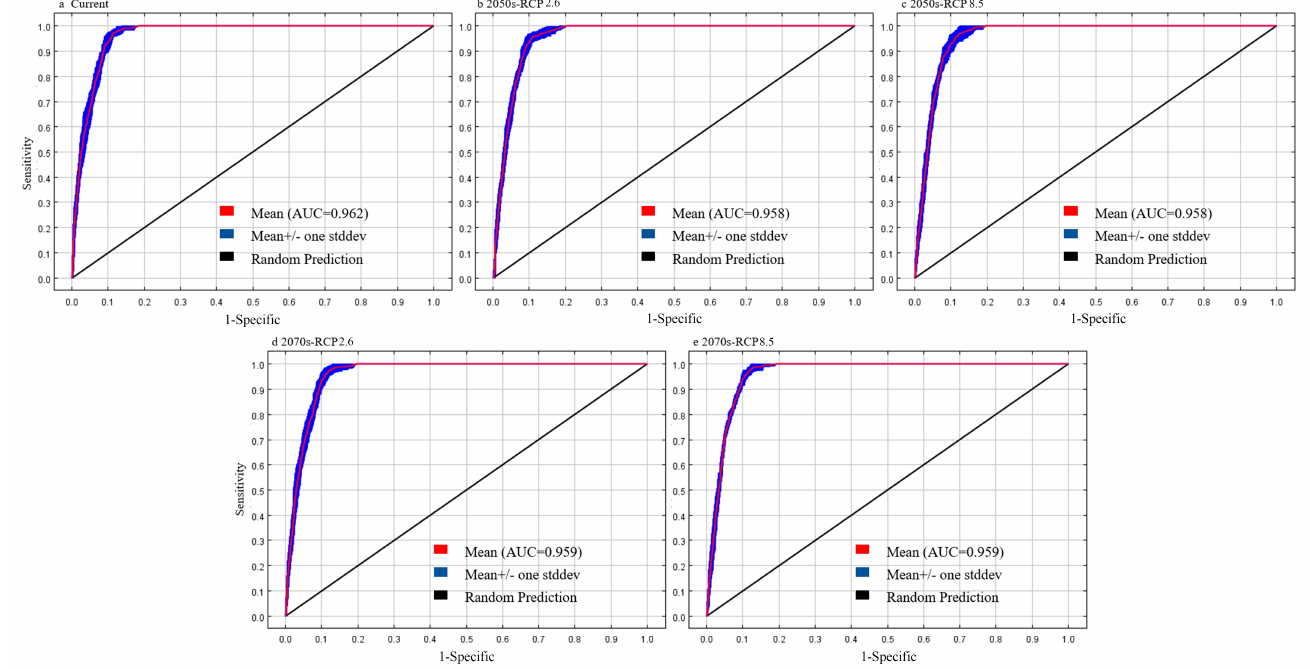
Table 3. Evaluate the AUC and TSS index values of the MaxENT model .